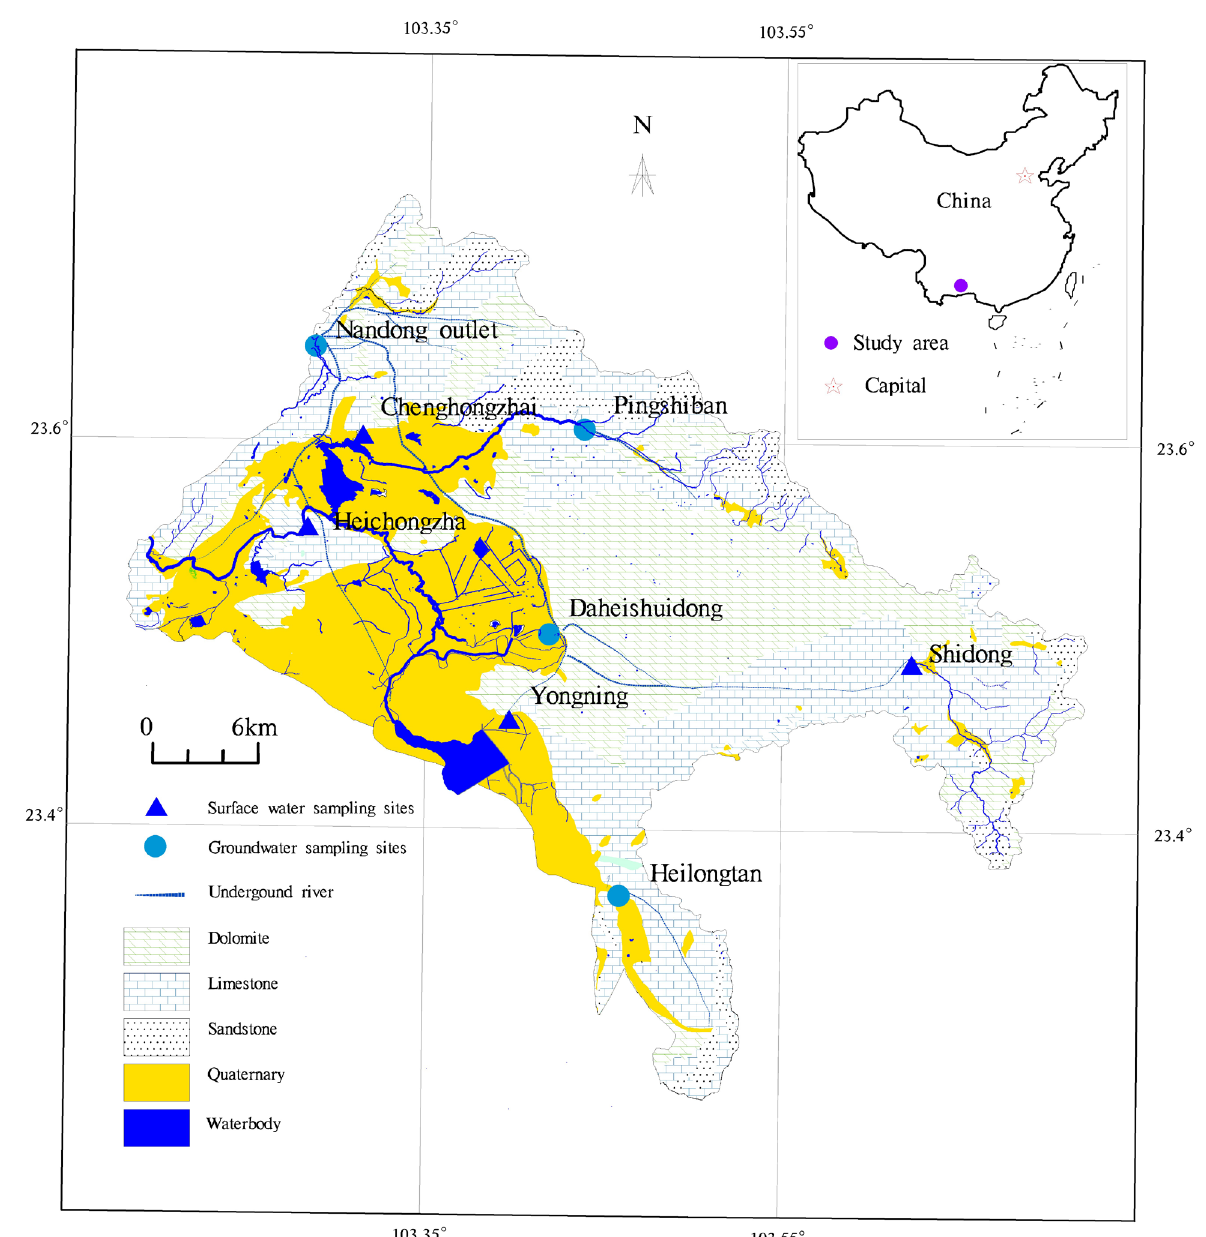
Figure 1. The hydrogeological map of NKWS. (created by the